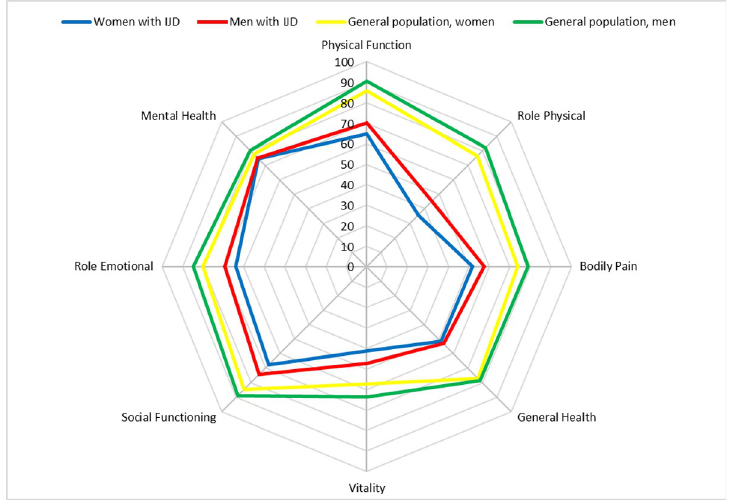
Fig 1. SF-36 scale scores (estimated marginal means) for men and women with inflammatory arthritis (adjusted for age and diagnosis) and for men and women from the general Norwegian population (adjusted for age).